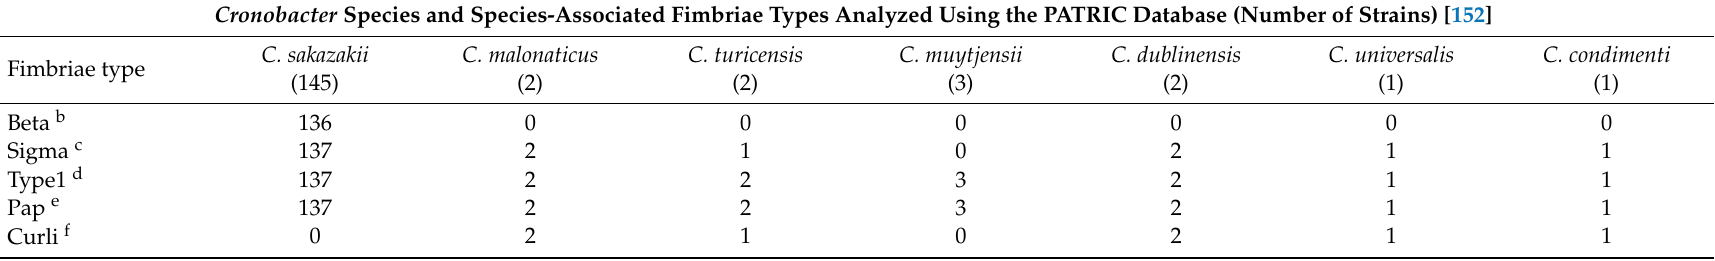
Table 6. Prevalence and distribution of type 1, Beta, Sigma, Pap, and Curli fimbriae gene clusters possessed by the seven Cronobacter species a . Cronobacter Species and Species-Associated Fimbriae Types Analyzed Using the PATRIC Database (Number of Strains)